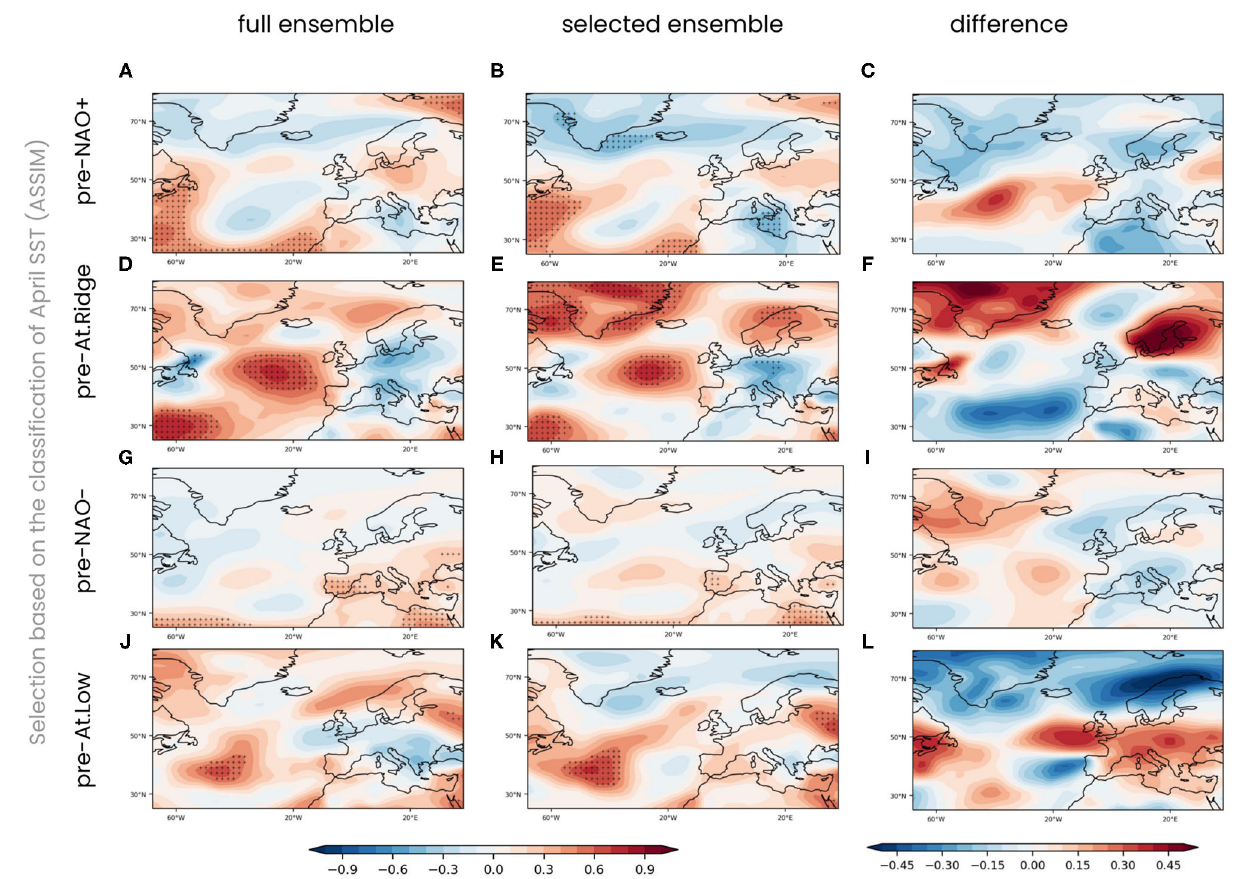
FIGURE 6 | Evaluation of a SST as predictor in the test ensemble. Anomaly correlation coefficients (ACC) for SLP, comparing the test ensemble to the reanalysis in 1902–2008. On the first row (uppermost) ACCs are calculated for years where April SST months in the pre-forecast data are classified as preceding NAO + , i.e., pre-NAO + . Similarly, the remaining three rows show ACCs for the case of pre-Atl. Ridge, pre-NAO − and pre-At. Low, respectively. Column-wise, ACCs are presented as follows: (A,D,G,J) the ensemble mean is taken over the full ensemble; (B,E,H,K) the ensemble mean is taken over the selected ensemble; (C,F,I,J) differences in ACC between the full and selected ensemble mean. Stippling represents correlation significant at the 95%